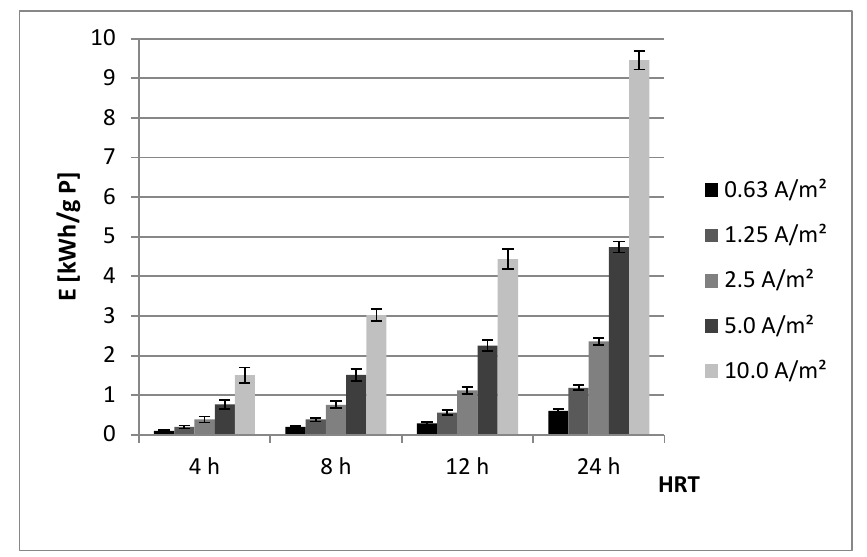
Figure 5. Influence of current density and HRT on electric energy consumption in the removal of phosphorus compounds in the rotating electrobiological disk contactor (mean and standard deviation).